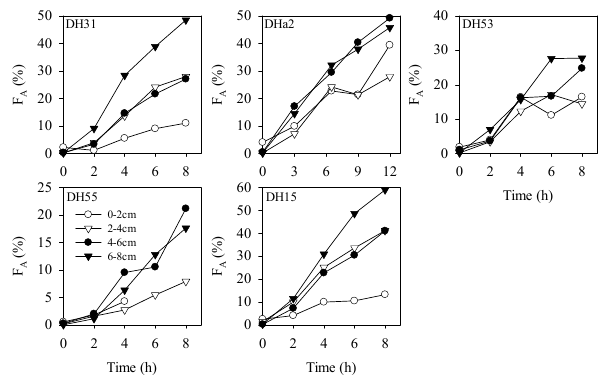
Fig. 4. Time course of 15 NH 4+ fraction (F A ) in E_Denit. 3